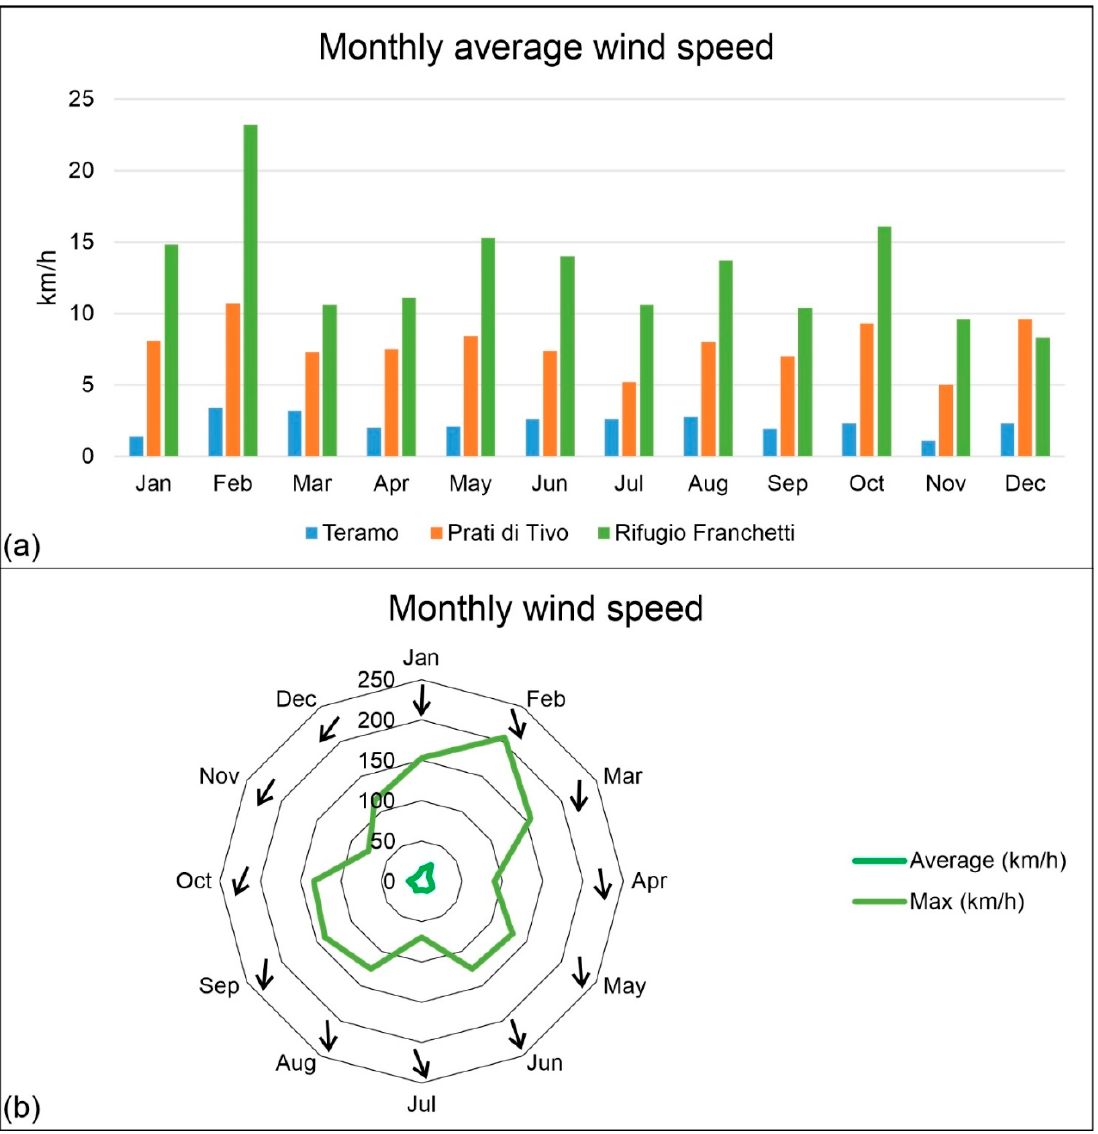
Figure 8. ( a ) Monthly average wind speed for the year 2020 and ( b ) monthly wind speed recorded at Rifugio Franchetti (2433 m a.s.l.). Black arrows indicate the monthly average direction of winds.